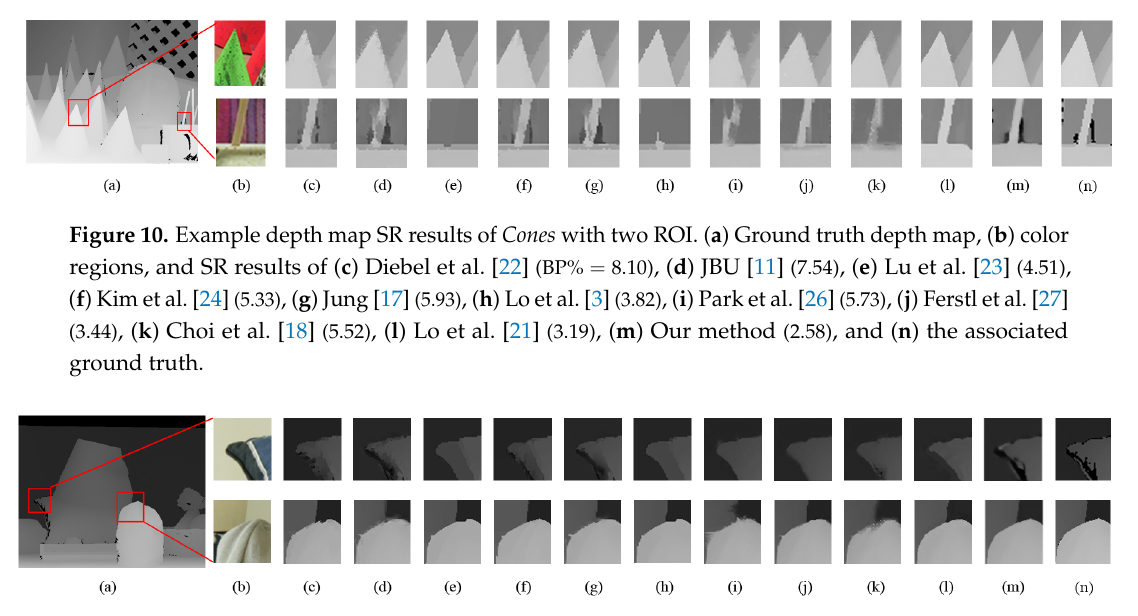
Figure 11. Example depth map SR results of Midd with two ROI. ( a ) Ground truth depth map, ( b ) color regions, and SR results of ( c ) Diebel et al. [22] (BP% = 2.96) , ( d ) JBU [11] (1.95) , ( e ) Lu et al. [23] (3.00) , ( f ) Kim et al. [24] (2.92) , ( g ) Jung [17] (2.10) , ( h ) Lo et al. [3] (1.80) , ( i ) Park et al. [26] (1.68) , ( j ) Ferstl et al. [27] (1.40) , ( k ) Choi et al. [18] (1.75) , ( l ) Lo et al. [21] (0.72) , ( m ) Our method (0.52) , and ( n ) the associated